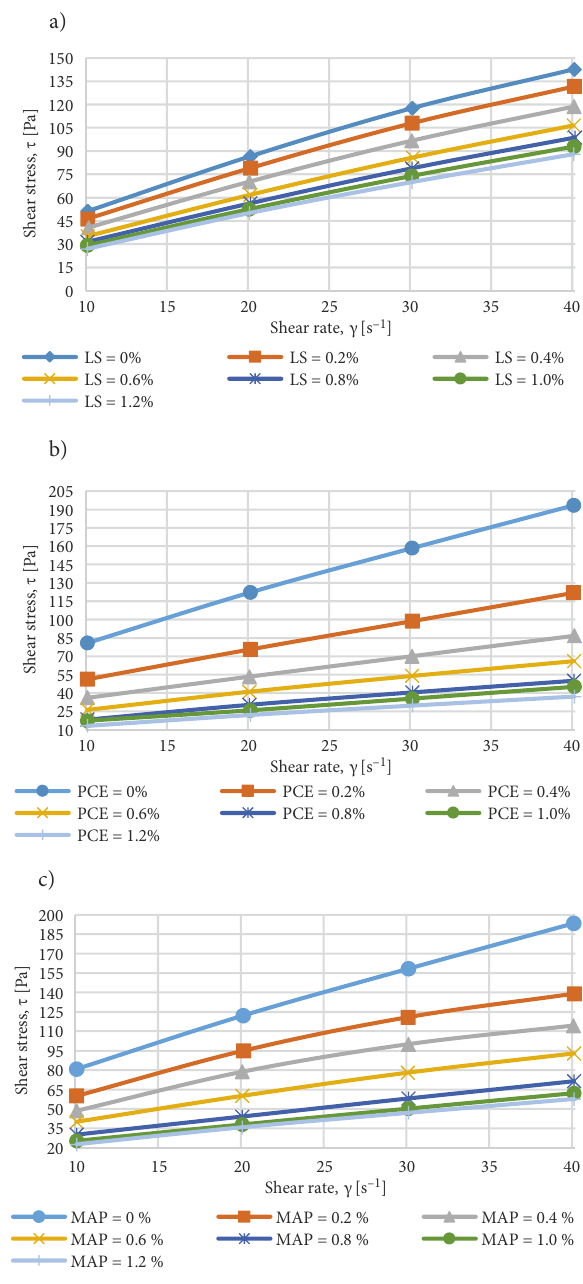
Figure 3. Dependence of the shear stress of the modified Portland cement pastes on the shear rate 10 minutes after the beginning of the paste mixing: a) with the plasticiser (LS); b) with the superplasticiser (PCE); c) with the superplasticiser